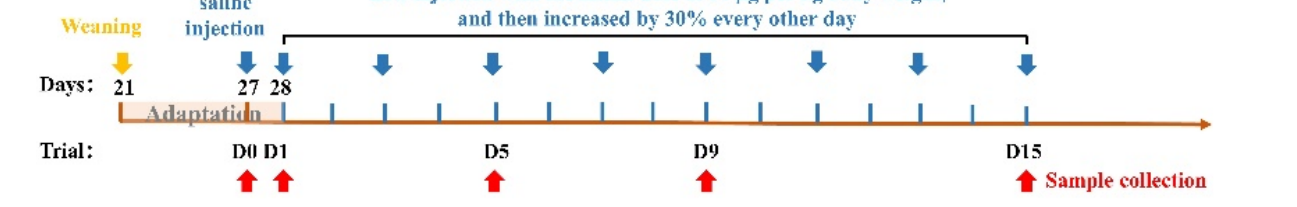
Figure 1. Effects Scheme of the experimental design. After a 7 d adaptation period, fifty piglets were randomly assigned to one of the five groups: (1) control group (pigs were injected with 0.90% sterile saline and slaughtered before 1 d of the trial); (2) LPS 1 d group (pigs were injected with LPS and slaughtered at 1 d of the trial); (3) LPS 5 d group (pigs were injected with LPS and slaughtered at 5 d of the trial); (4) LPS 9 d group (pigs were injected with LPS and slaughtered at 9 d of the trial); (5) LPS 15 d group (pigs were injected with LPS and slaughtered at 15 d of the trial). LPS, lipopolysaccharide. Table 1. Composition and nutrient levels of the diets for weaned piglets (air-dried basis,%). Items